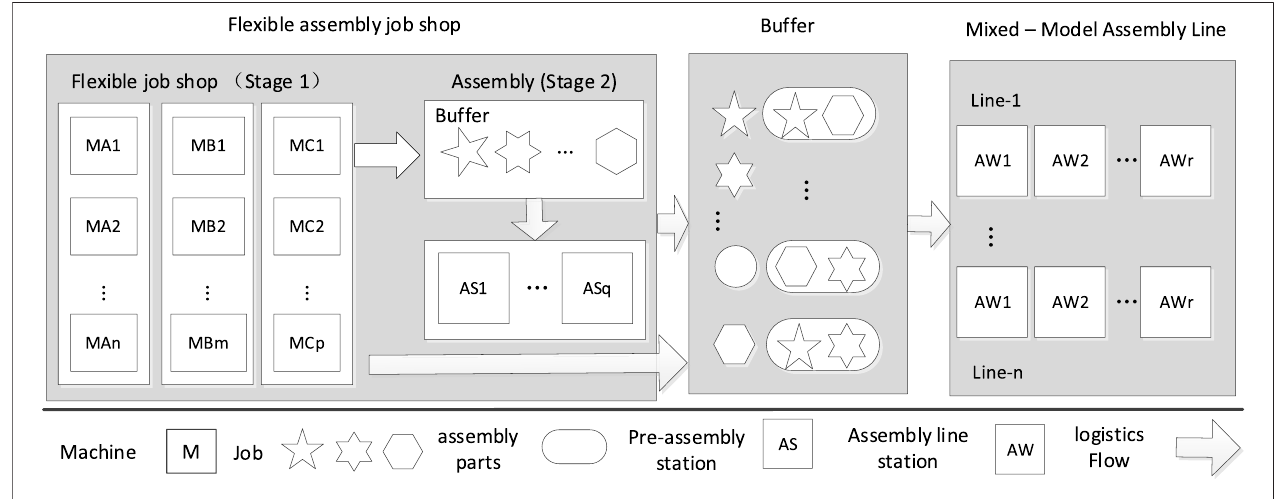
FIGURE 1 | Structure of fl exible assembly job-shop with following mixed-model assembly